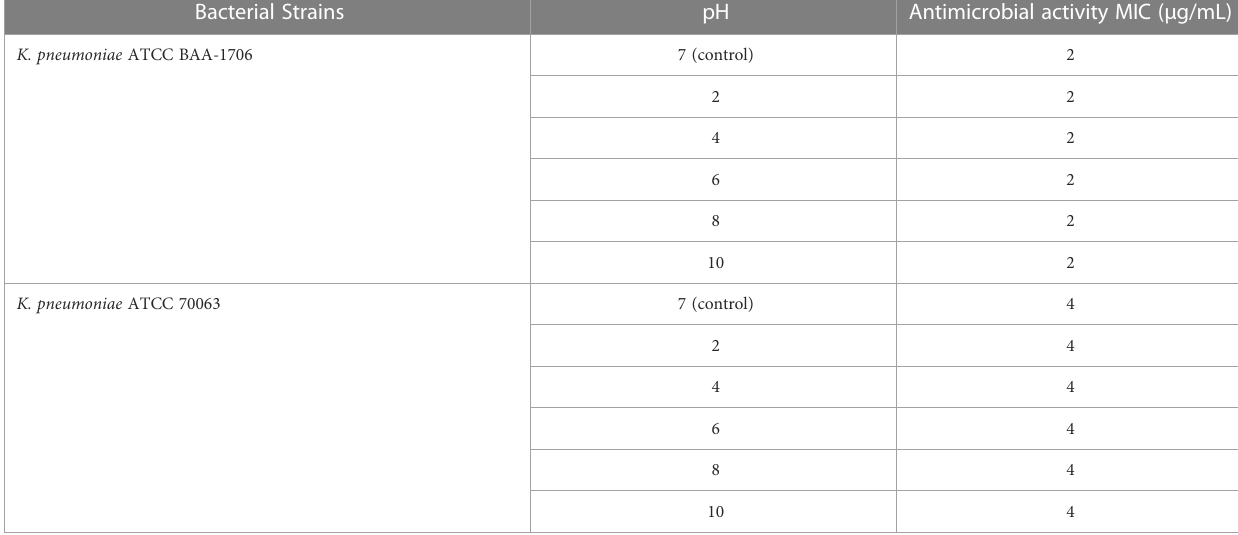
TABLE 4 The MIC values of the K11 against K. pneumoniae reference strains after different pH